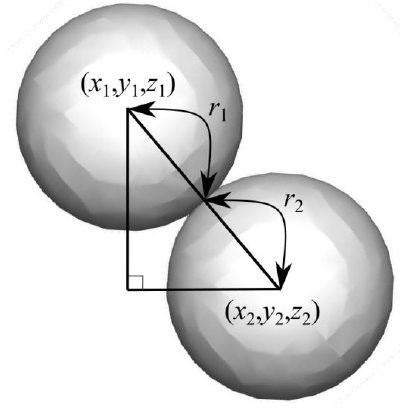
Figure 2. Collision detection.